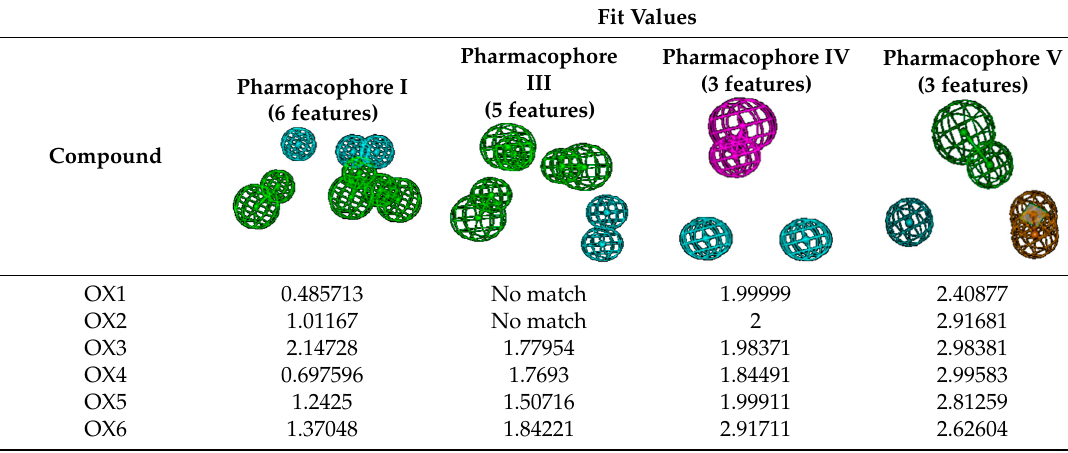
Green spheres = hydrogen acceptor; pink spheres = hydrogen-donor; blue sphere = hydrophobic; yellow spheres = aromatic.